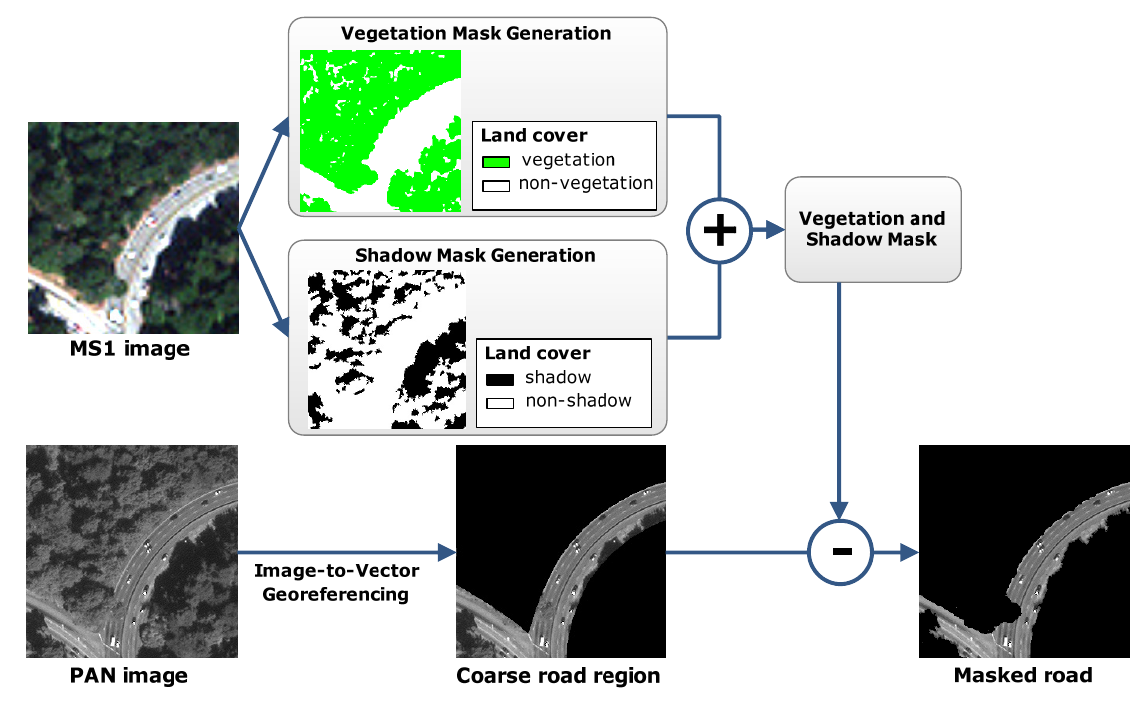
Figure 3. Flow diagram of the road